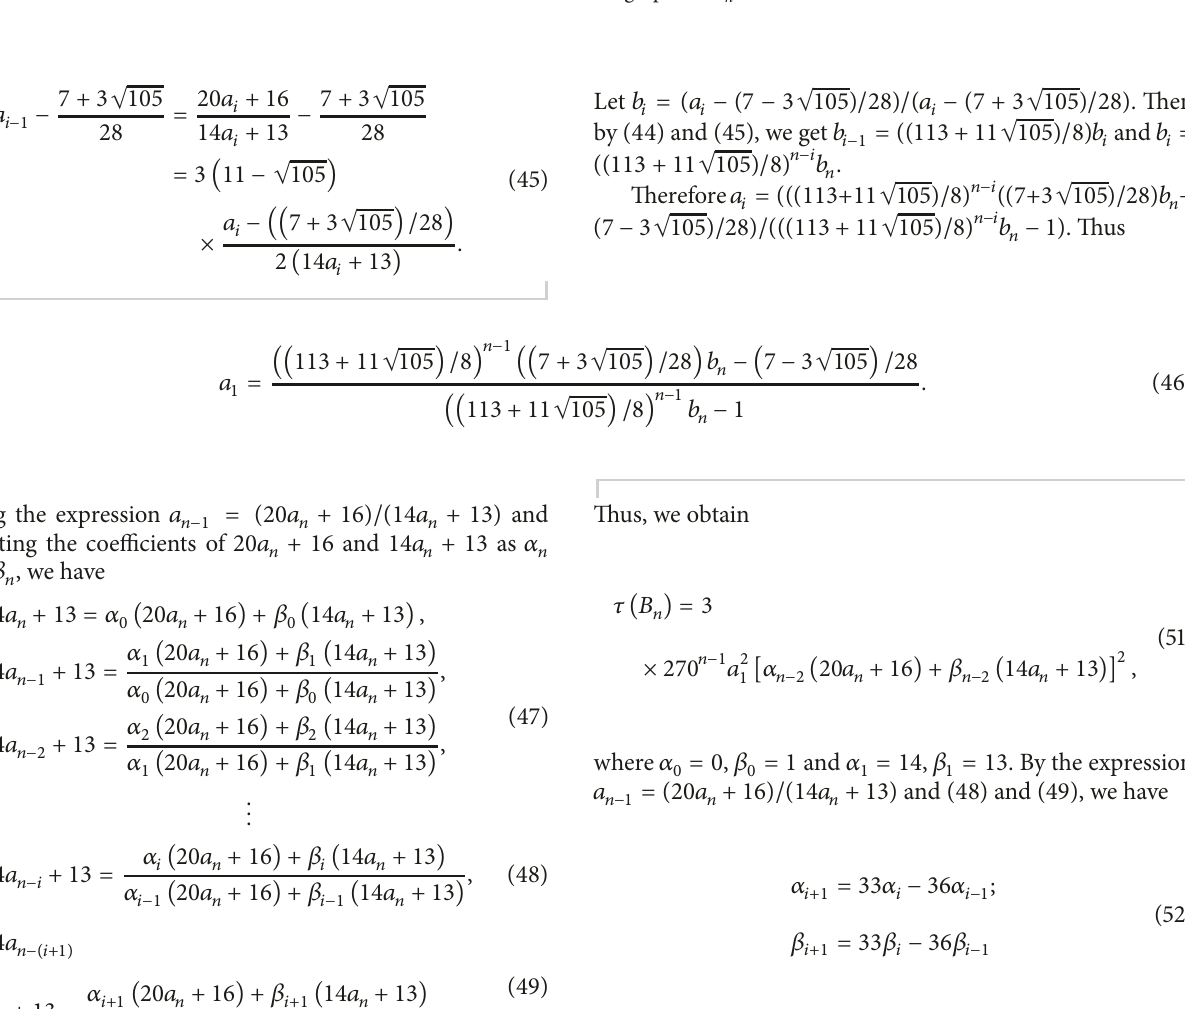
Figure 5: The first three graphs of 𝐵 𝑛